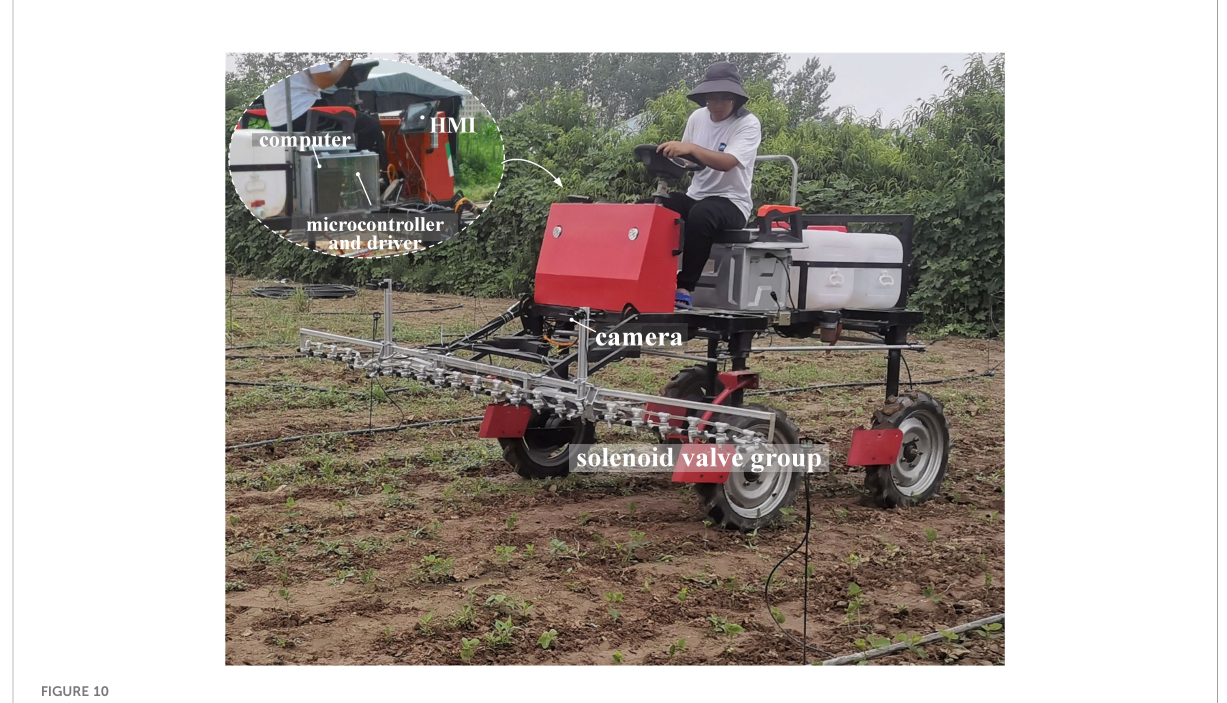
FIGURE 10 Experimental equipment.